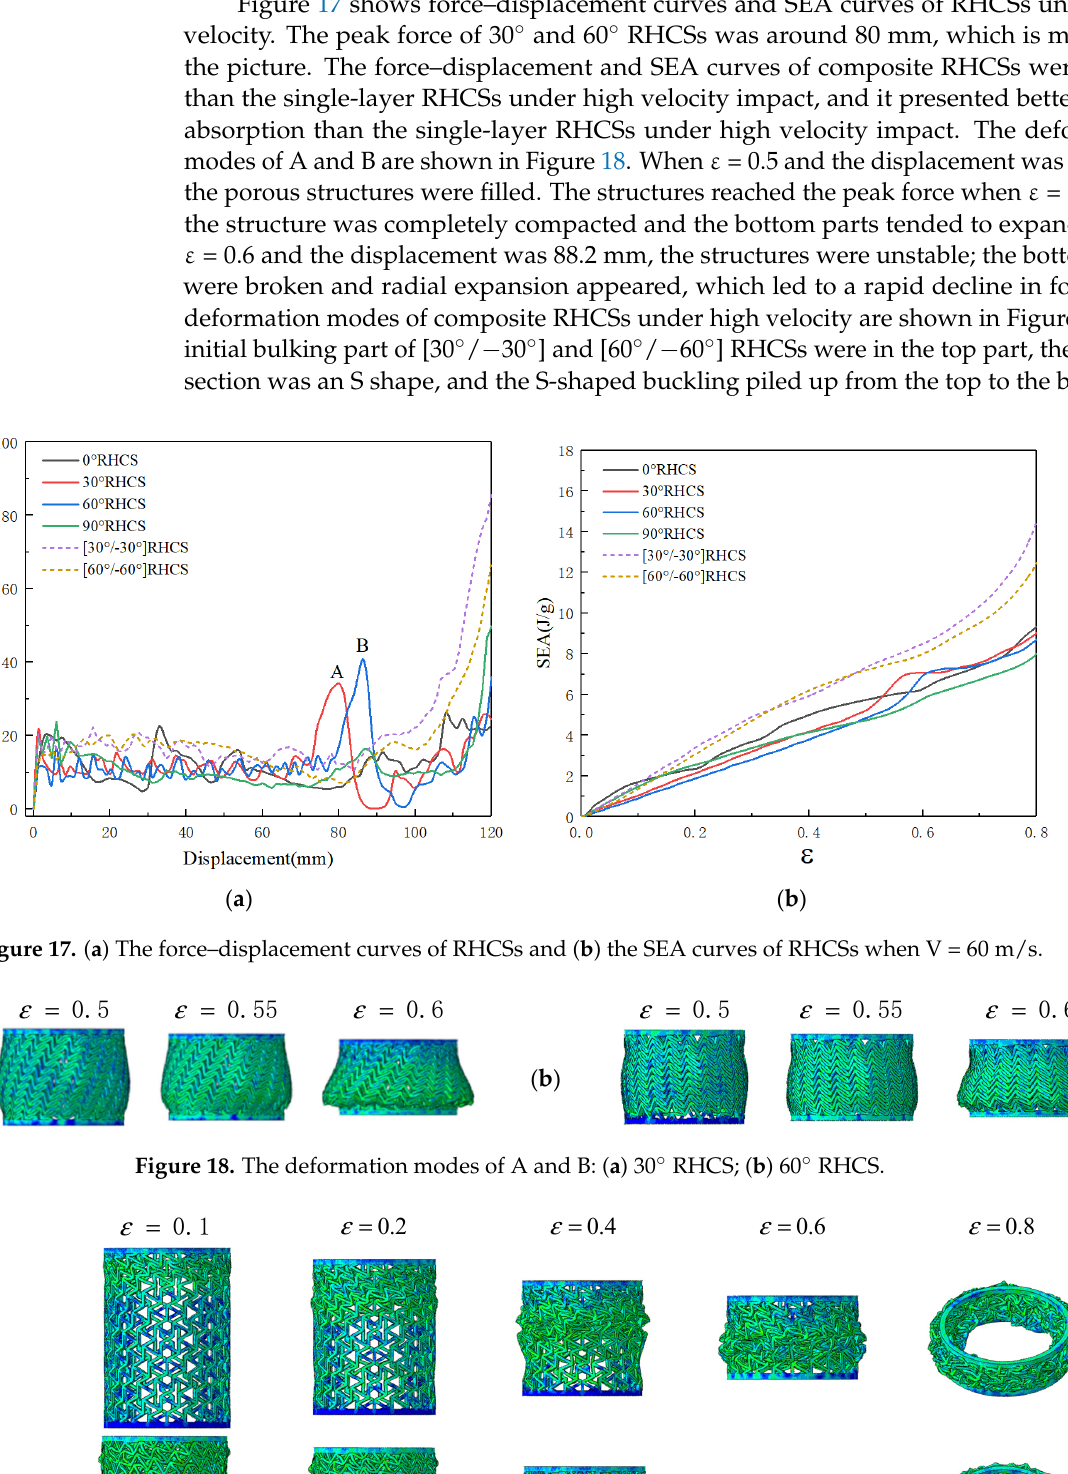
Figure 16. The deformation process of composite RHCSs when V = 10 m/s: ( a ) [30°/ − 30°] RHCS; ( b ) [60°/ − 60°] RHCS.